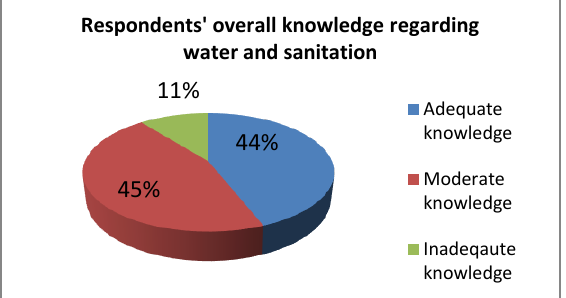
Figure 1: Respondents’ overall knowledge regarding water and